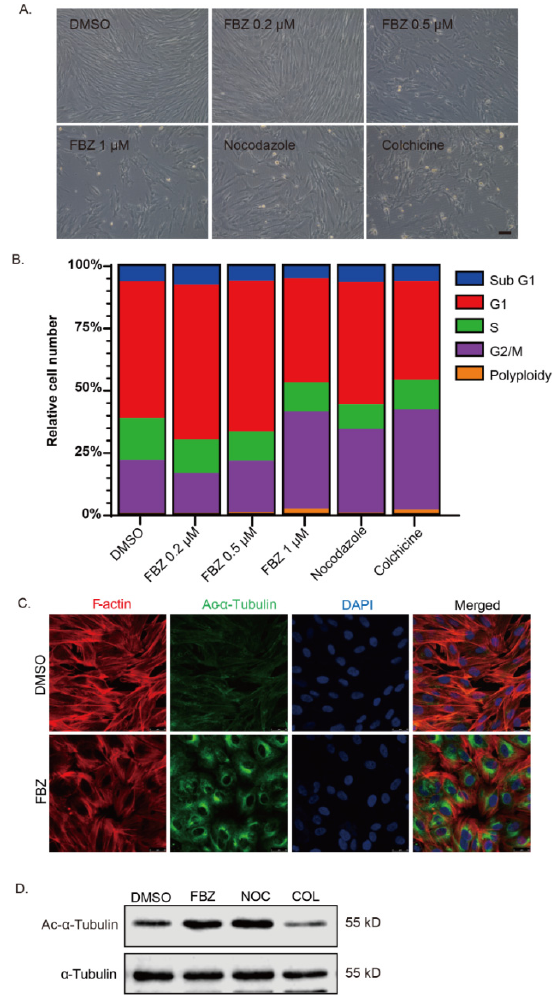
Figure 3. Fenbendazole disrupted microtubule dynamic and caused cell cycle arrest. ( A ) IMR-90 cells were treated with FBZ, nocodazole, colchicine (concentration as indicated), or vehicle for 48 h. Phase-contrast microscopy images showed the morphology of treated cells (magnification 200×). ( B ) IMR-90 cells were treated with indicated reagents for 48 h; alterations in the cell cycle distribution were detected by flow cytometry after PI staining. ( C ) IMR-90 cells were treated with or without 0.5 µ M FBZ for 48 h; confocal images were captured after immunofluorescence staining of acety- lated α -tubulin (green) and TRITC-conjugated phalloidin (red). ( D ) IMR-90 cells treated with FBZ (0.2 µ M), nocodazole (0.1 µ M), and colchicine (0.05 µ M) for 48 h; acetylated α -tubulin and α -tubulin were assessed by